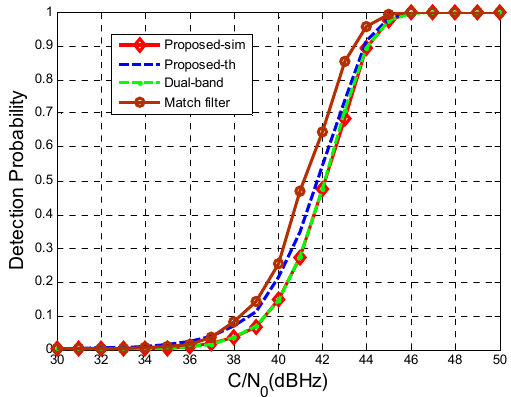
Figure 6. Detection probabilities of different methods. Table 1. Sampling frequencies and intermediate frequencies.